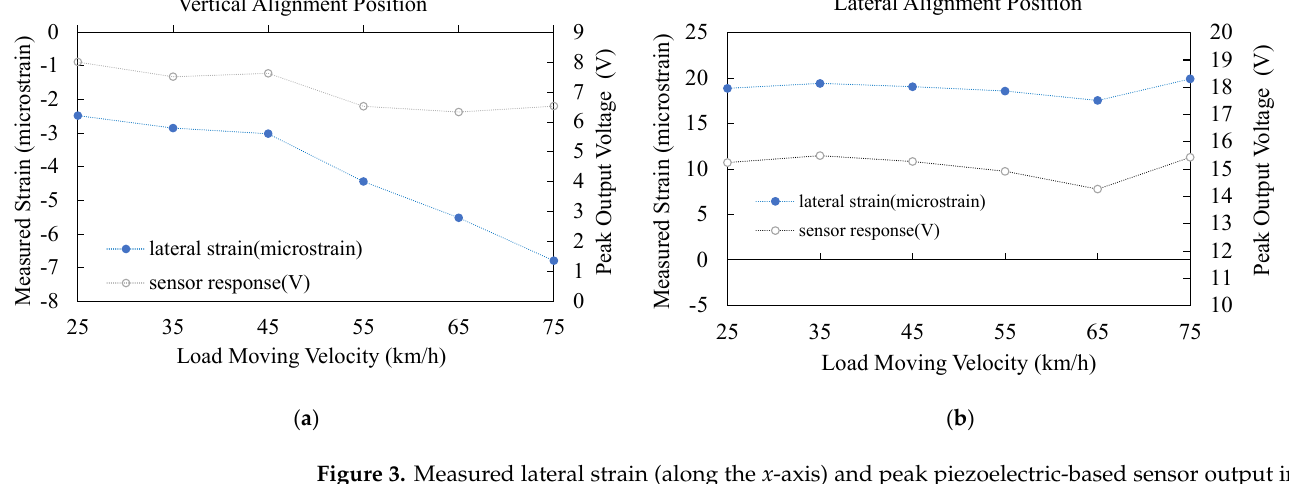
Figure 3. Measured lateral strain (along the x -axis) and peak piezoelectric-based sensor output in response to the dynamic load moving velocity when there is no bottom-up crack existing in the asphalt concrete pavement (crack depth = 0 cm): ( a ) sensor is vertically aligned (along the y -axis); ( b ) sensor is laterally aligned (along the x -axis).